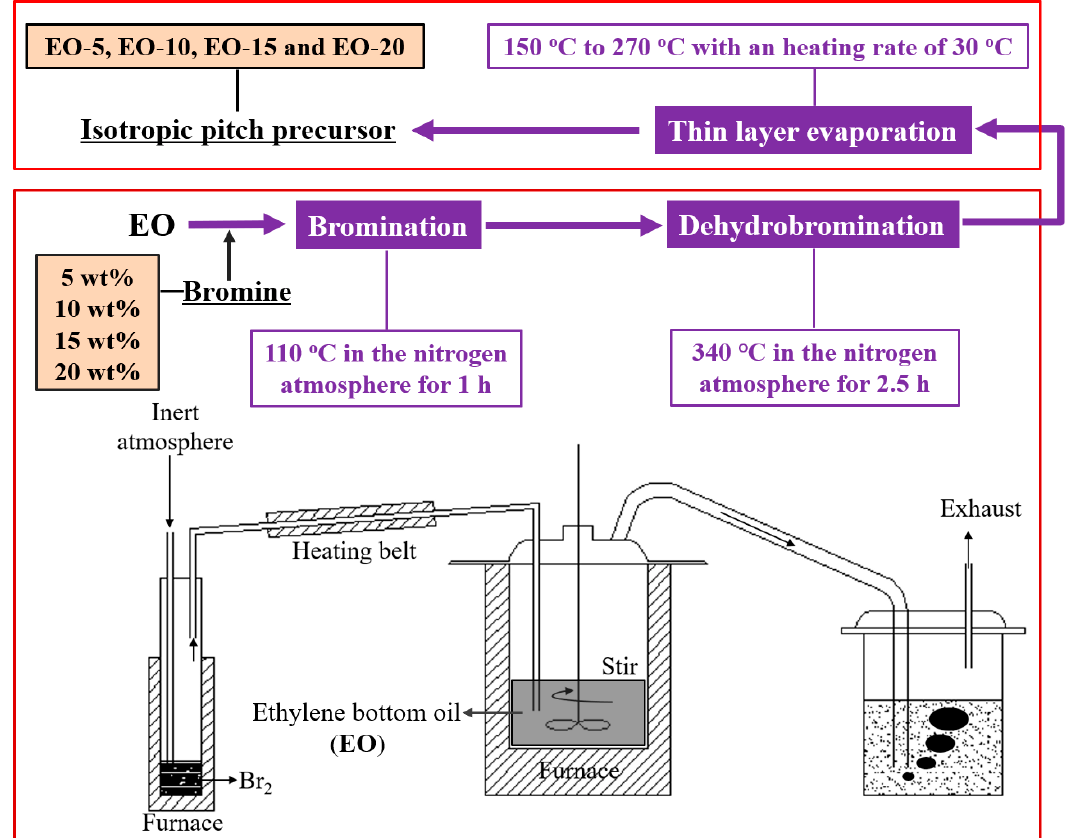
Figure 1. The preparation process of isotropic pitch precursors by bromination-dehydrobromination.